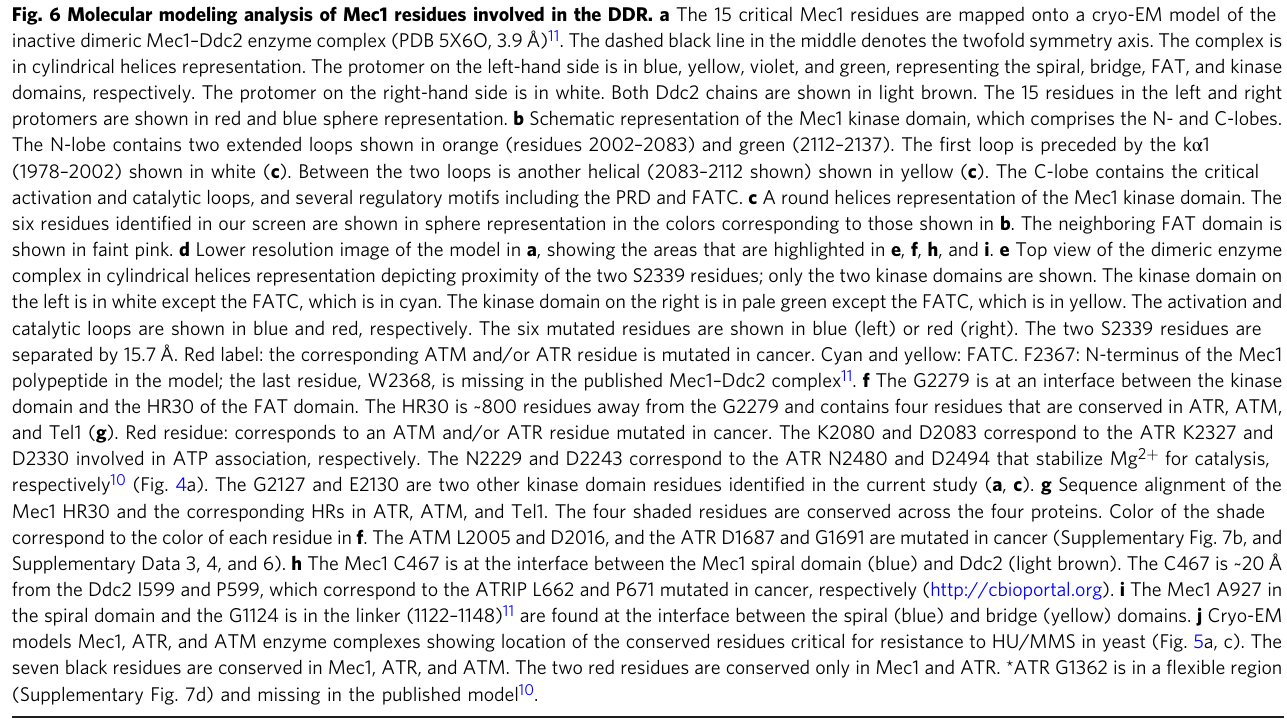
Fig. 6 Molecular modeling analysis of Mec1 residues involved in the DDR. a The 15 critical Mec1 residues are mapped onto a cryo-EM model of the inactive dimeric Mec1 – Ddc2 enzyme complex (PDB 5X6O, 3.9 Å) 11 . The dashed black line in the middle denotes the twofold symmetry axis. The complex is in cylindrical helices representation. The protomer on the left-hand side is in blue, yellow, violet, and green, representing the spiral, bridge, FAT, and kinase domains, respectively. The protomer on the right-hand side is in white. Both Ddc2 chains are shown in light brown. The 15 residues in the left and right protomers are shown in red and blue sphere representation. b Schematic representation of the Mec1 kinase domain, which comprises the N- and C-lobes. The N-lobe contains two extended loops shown in orange (residues 2002 – 2083) and green (2112 – 2137). The fi rst loop is preceded by the k α 1 (1978 – 2002) shown in white ( c ). Between the two loops is another helical (2083 – 2112 shown) shown in yellow ( c ). The C-lobe contains the critical activation and catalytic loops, and several regulatory motifs including the PRD and FATC. c A round helices representation of the Mec1 kinase domain. The six residues identi fi ed in our screen are shown in sphere representation in the colors corresponding to those shown in b . The neighboring FAT domain is shown in faint pink. d Lower resolution image of the model in a , showing the areas that are highlighted in e , f , h , and i . e Top view of the dimeric enzyme complex in cylindrical helices representation depicting proximity of the two S2339 residues; only the two kinase domains are shown. The kinase domain on the left is in white except the FATC, which is in cyan. The kinase domain on the right is in pale green except the FATC, which is in yellow. The activation and catalytic loops are shown in blue and red, respectively. The six mutated residues are shown in blue (left) or red (right). The two S2339 residues are separated by 15.7 Å. Red label: the corresponding ATM and/or ATR residue is mutated in cancer. Cyan and yellow: FATC. F2367: N-terminus of the Mec1 polypeptide in the model; the last residue, W2368, is missing in the published Mec1 – Ddc2 complex 11 . f The G2279 is at an interface between the kinase domain and the HR30 of the FAT domain. The HR30 is ~800 residues away from the G2279 and contains four residues that are conserved in ATR, ATM, and Tel1 ( g ). Red residue: corresponds to an ATM and/or ATR residue mutated in cancer. The K2080 and D2083 correspond to the ATR K2327 and D2330 involved in ATP association, respectively. The N2229 and D2243 correspond to the ATR N2480 and D2494 that stabilize Mg 2 + for catalysis, respectively 10 (Fig. 4a). The G2127 and E2130 are two other kinase domain residues identi fi ed in the current study ( a , c ). g Sequence alignment of the Mec1 HR30 and the corresponding HRs in ATR, ATM, and Tel1. The four shaded residues are conserved across the four proteins. Color of the shade correspond to the color of each residue in f . The ATM L2005 and D2016, and the ATR D1687 and G1691 are mutated in cancer (Supplementary Fig. 7b, and Supplementary Data 3, 4, and 6). h The Mec1 C467 is at the interface between the Mec1 spiral domain (blue) and Ddc2 (light brown). The C467 is ~20 Å from the Ddc2 I599 and P599, which correspond to the ATRIP L662 and P671 mutated in cancer, respectively (http://cbioportal.org). i The Mec1 A927 in the spiral domain and the G1124 is in the linker (1122 – 1148) 11 are found at the interface between the spiral (blue) and bridge (yellow) domains. j Cryo-EM models Mec1, ATR, and ATM enzyme complexes showing location of the conserved residues critical for resistance to HU/MMS in yeast (Fig. 5a, c). The seven black residues are conserved in Mec1, ATR, and ATM. The two red residues are conserved only in Mec1 and ATR. *ATR G1362 is in a fl exible region (Supplementary Fig. 7d) and missing in the published model 10